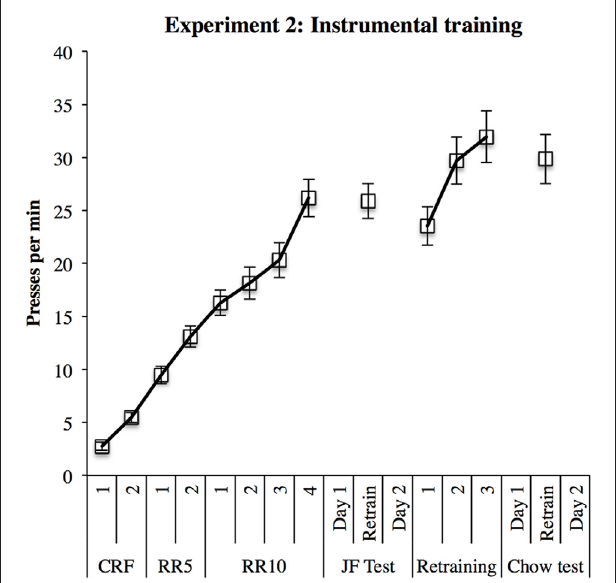
FIGURE 5 | Total energy intake during context conditioning in Experiment 2. On average, rats ate more in 24-h periods beginning with a JF context session ∗ p = 0.002. Since rats were group-housed, consumption in daily context sessions was summed for each cage.